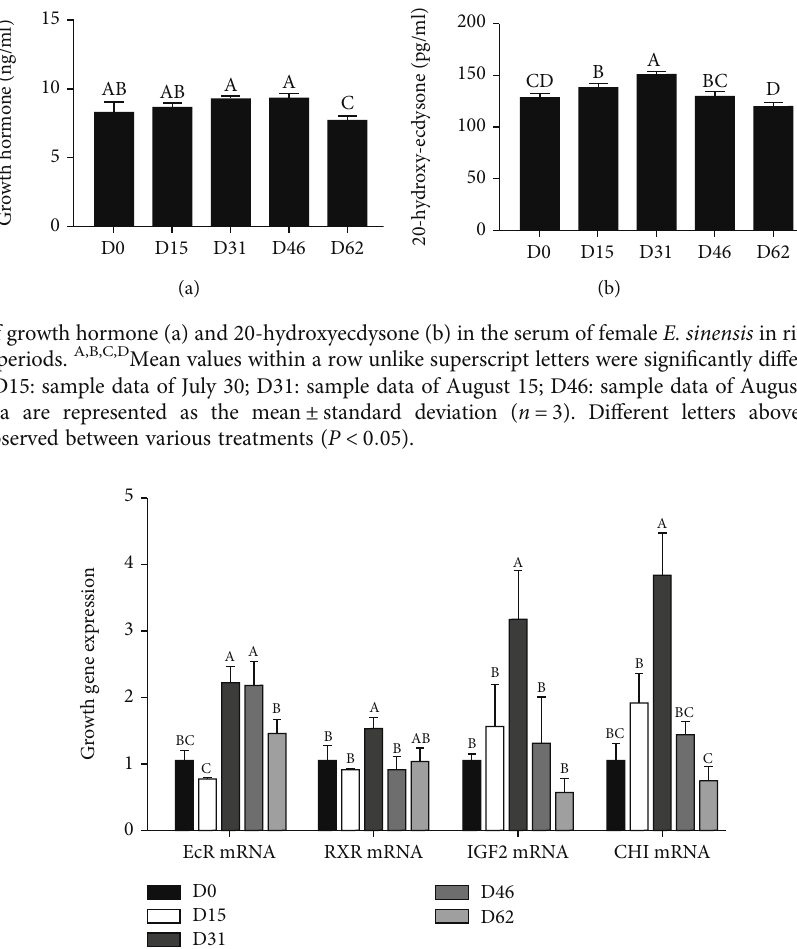
Figure 4: The growth gene expression levels in the muscle of female E. sinensis in rice-crab culture systems at di ff erent developmental periods. A,B,C Mean values within a row unlike superscript letters were signi fi cantly di ff erent ( P < 0 : 05 ). Note: D0: sample data of July 15; D15: sample data of July 30; D31: sample data of August 15; D46: sample data of August 30; D62: sample data of September 15. The data are represented as the mean ± standard deviation ( n = 3 ). Di ff erent letters above the columns represent signi fi cant di ff erences observed between various treatments ( P < 0 : 05